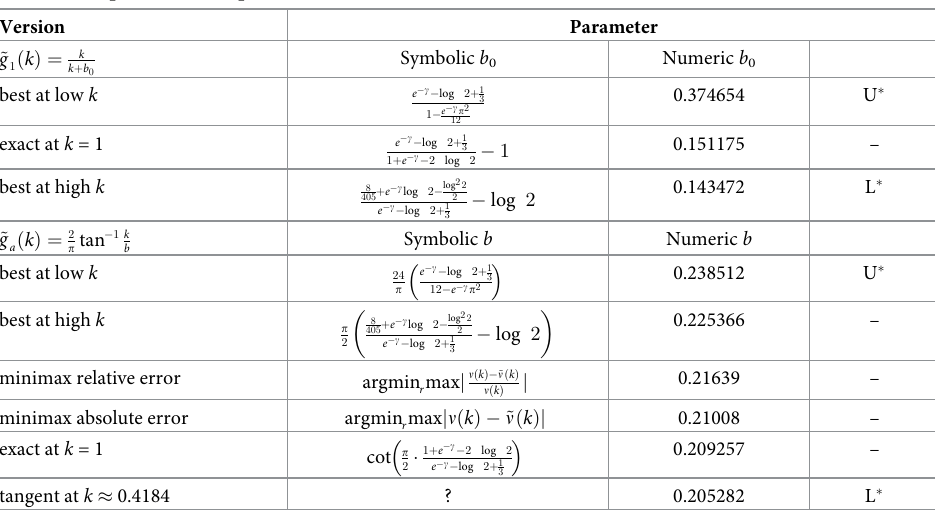
Table 2. Comparison of